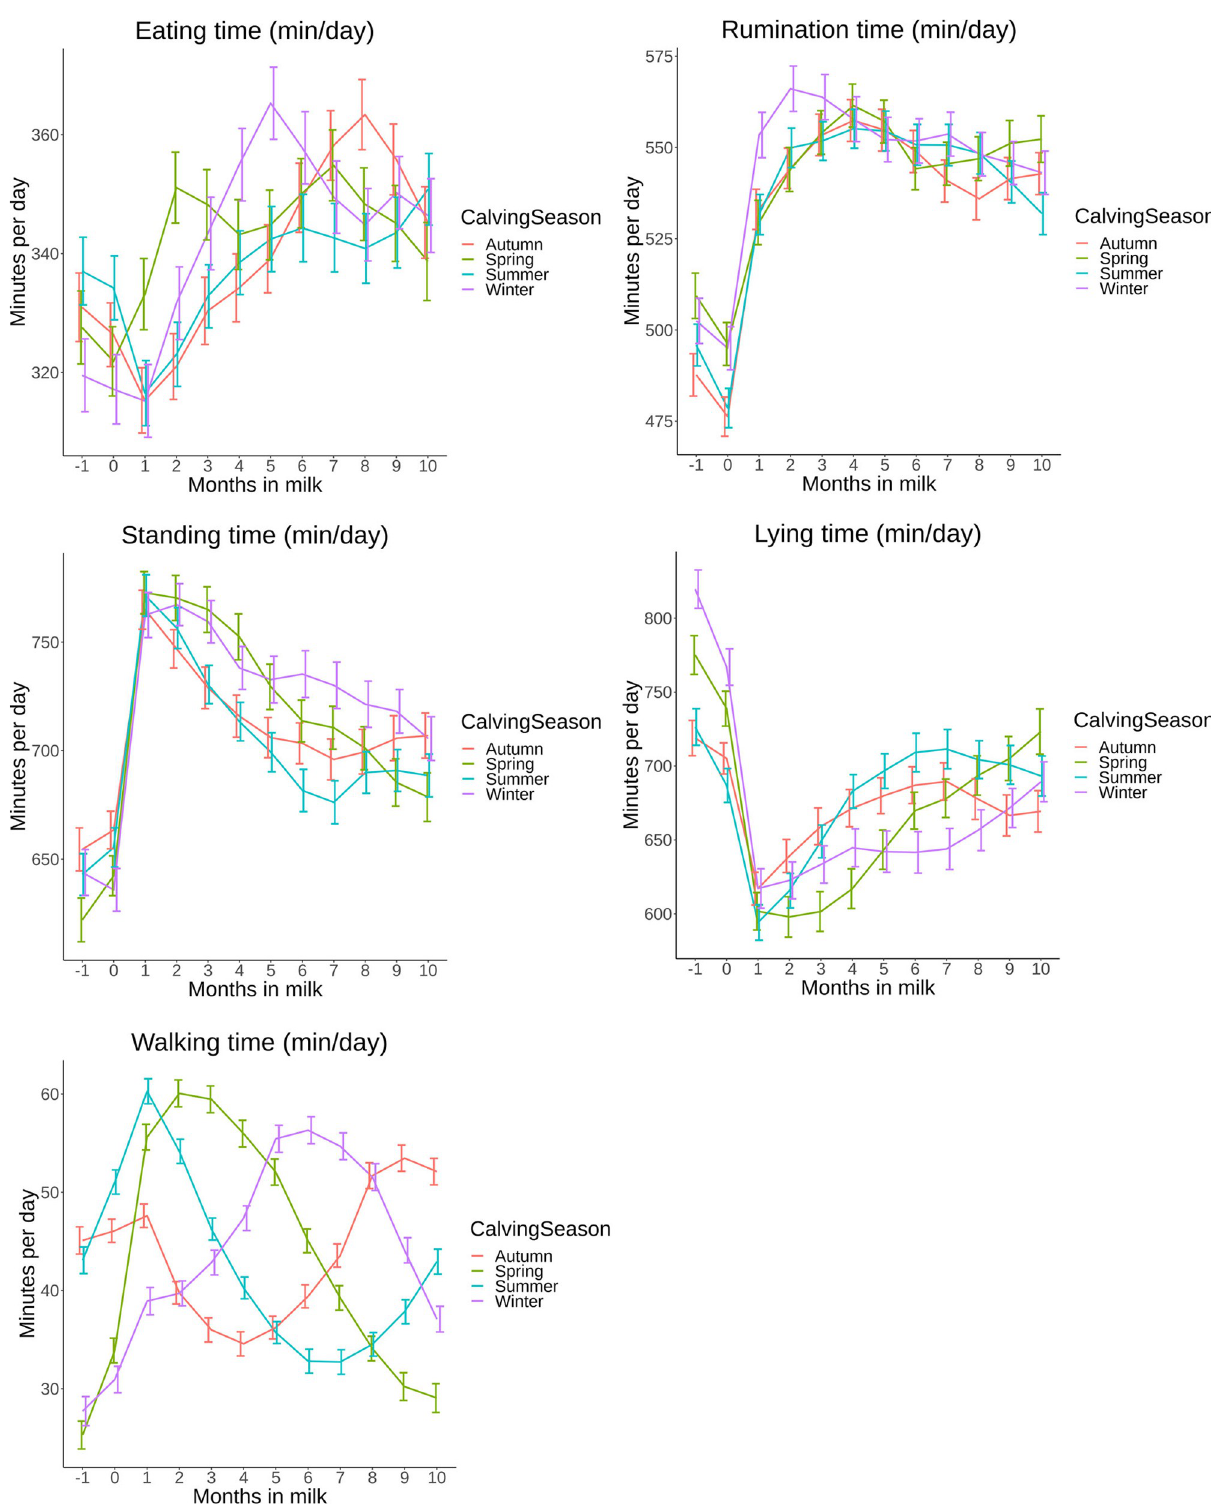
Fig 5. A,B,C,D,E: Time budget parameters in minutes per day (min/day) based on least square means (LSM) with 95% confidence intervals (95% CI) grouped by calving season (Spring, Summer, Autumn, Winter) on 8 commercial dairy farms in The Netherlands from 1 month before calving until 10 months in milk with “month 0” consisting of d-1, d0 and